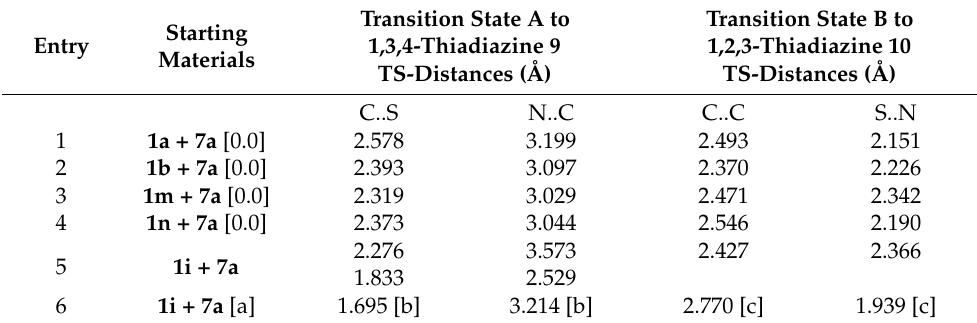
Table 2. DFT-calculated distances of the reacting atoms in the transition states A or B for the cycloadditions of azoalkene 7a with different thioketones 1 leading to 9 or 10 .